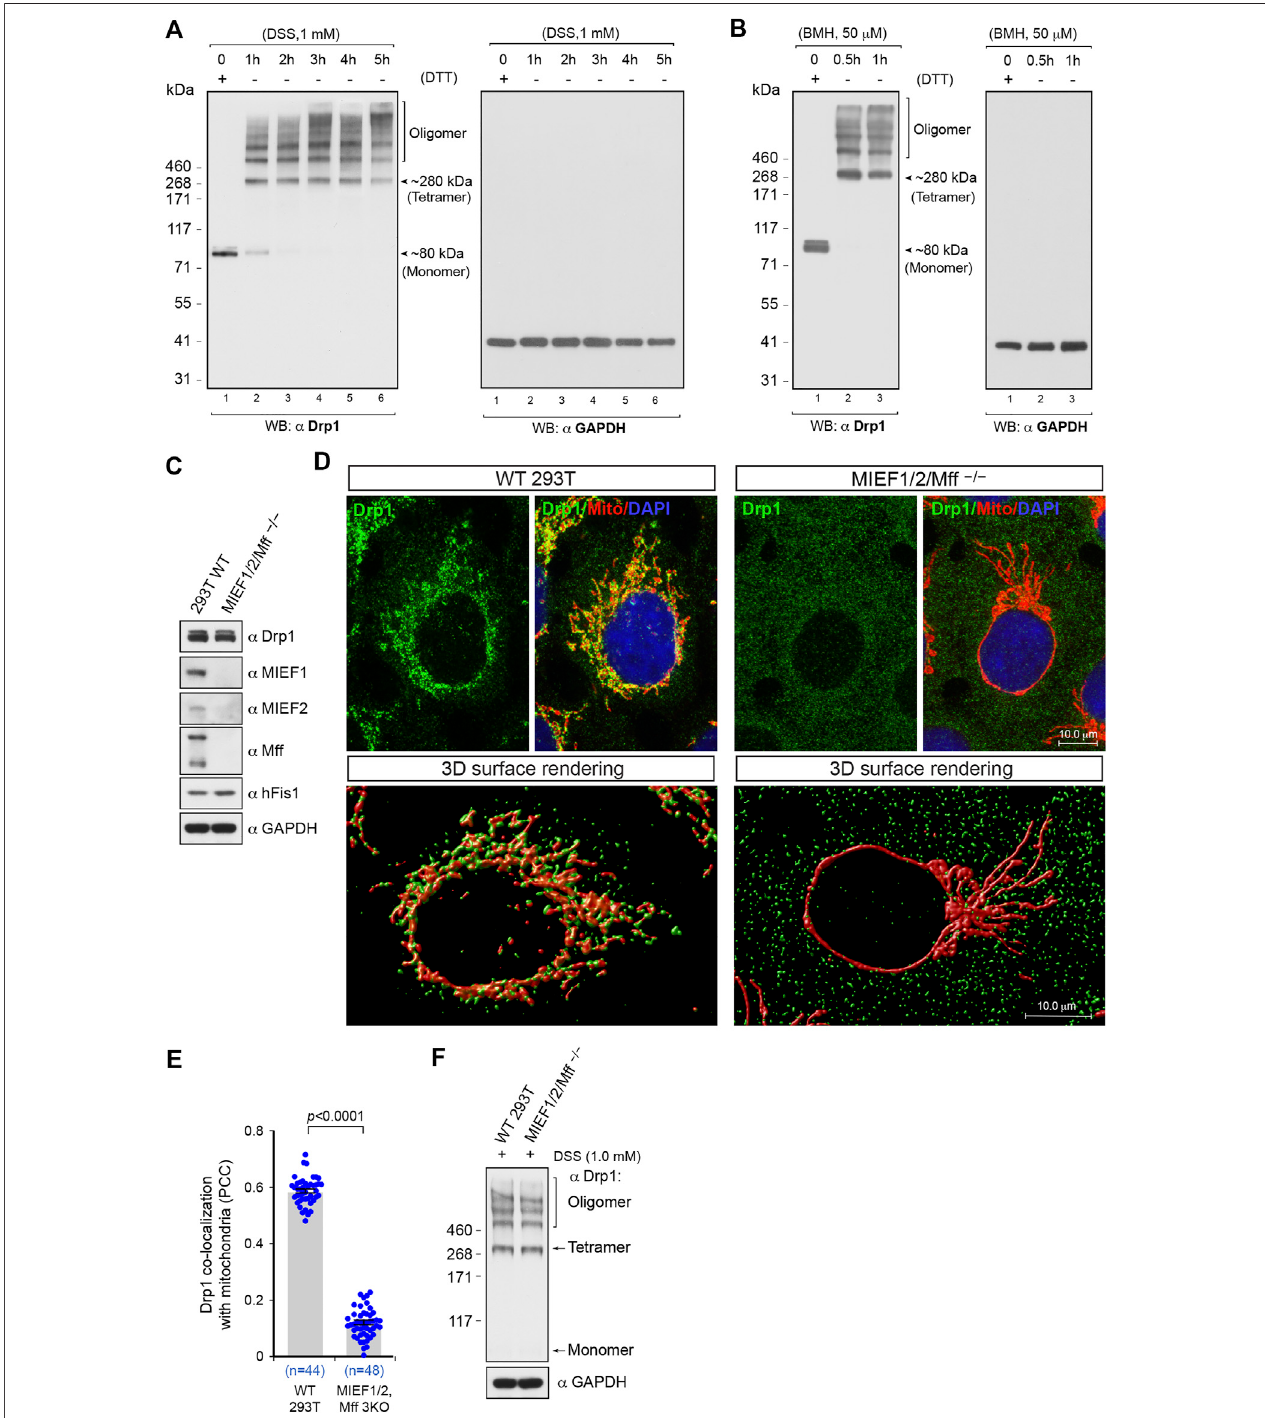
FIGURE 1 | The oligomeric state of Drp1 in human (293T) cells in vivo and the receptor-mediated recruitment of Drp1 to mitochondria enhances Drp1 oligomerization. (A,B) In 293T cells, Drp1 exists as multiple self-assembly subunits including the minimal self-assembly unit at ∼ 280 kDa (probably corresponding to tetramers) and several higher order units. 293T cells were treated with the cell-permeable crosslinking reagent DSS (A) or BMH (B) in a time course as indicated. Cell lysates were analyzed by Western blotting as indicated. The endogenous monomeric protein GAPDH was used as negative control to rule out nonspeci fi c crosslinking. (C) The single cell derived colony of MIEF1/2/Mff − / − 293T cells (triple receptor knock-out) was validated by Western blotting analysis with indicated antibodies. WT 293T cells were used as control. (D) Confocal images and 3D surface rendering of mitochondrial morphology and endogenous Drp1 distribution in WT